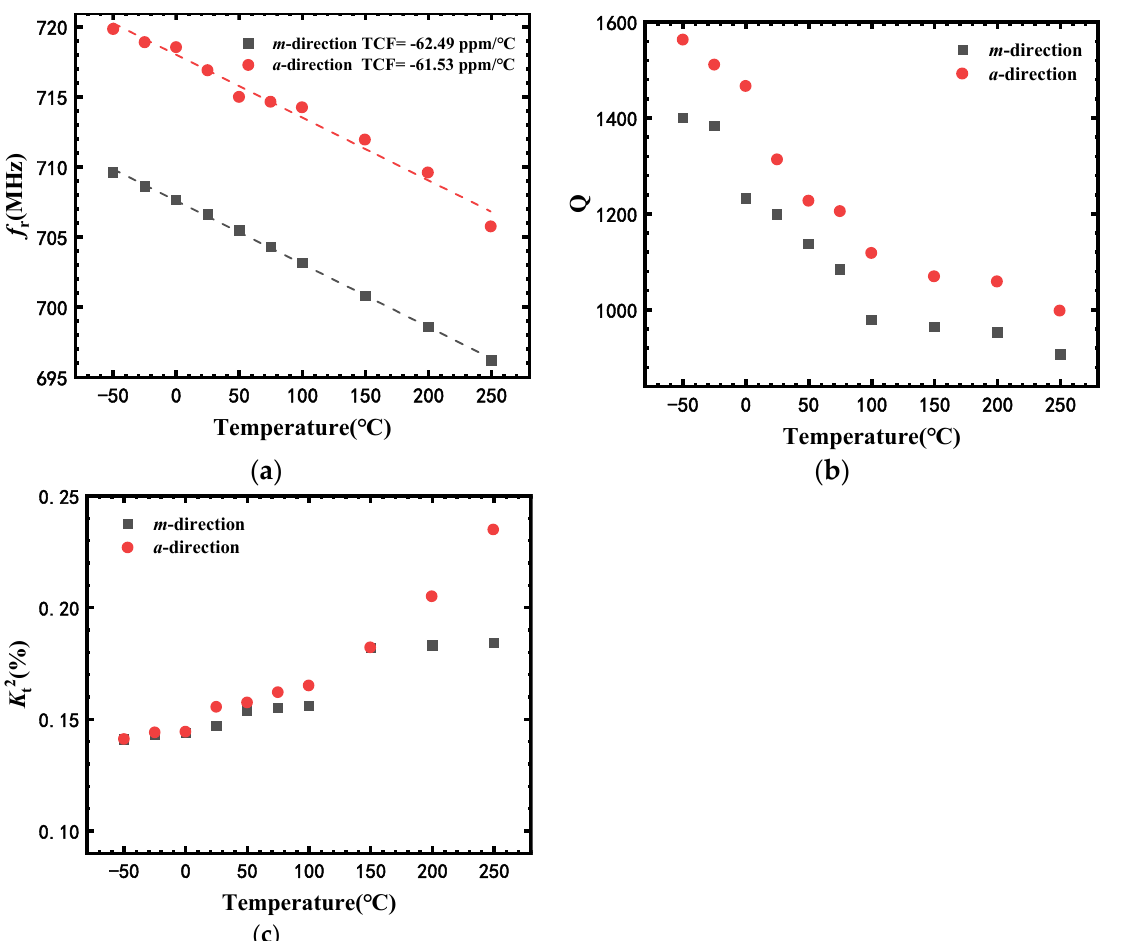
of sensors with different acoustic t